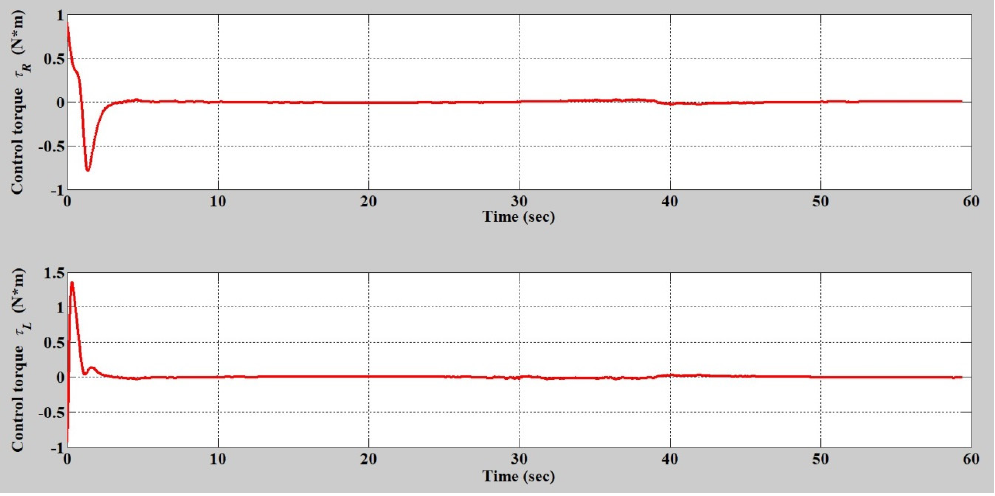
= 1.9 m, y = 0 m). c c